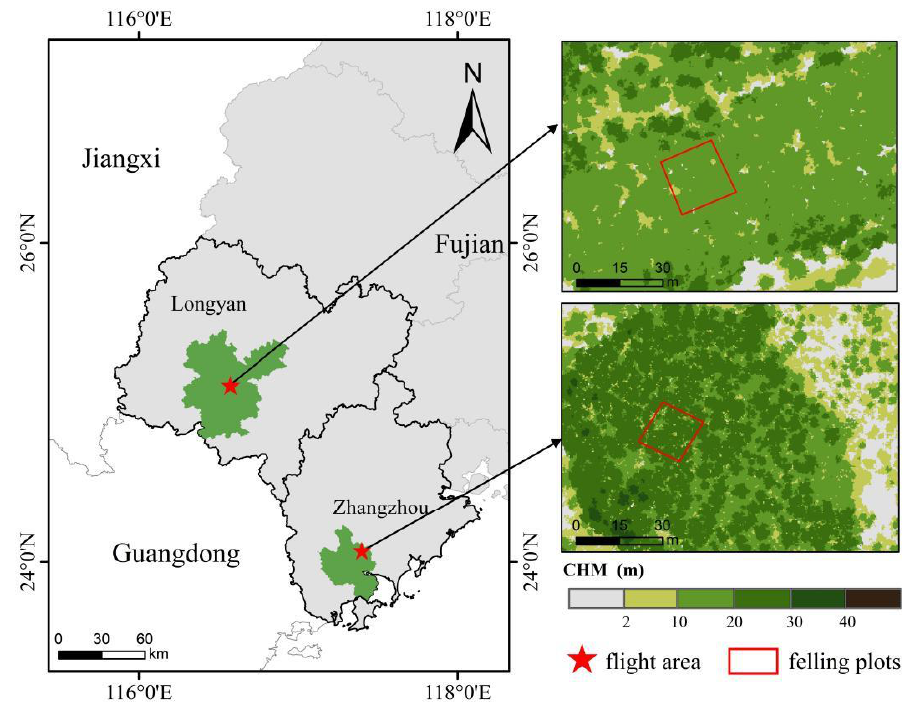
Figure 1. Locations of the experimental sites: Baisha ( upper right ) and Yuanling ( lower right ). CHM represents canopy-height model data generated from UAV Lidar.